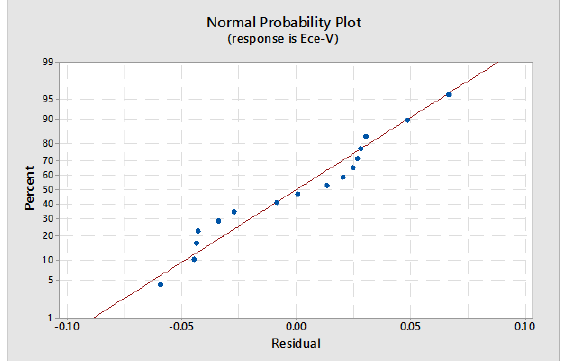
Figure 4. Multiple linear regression result of 21st March, 2010 with different combinations of bands and indices.